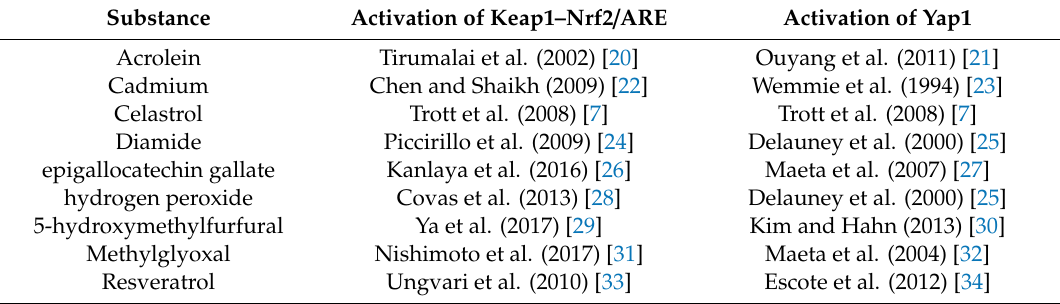
Table 1. A selection of substances shown to activate both the Keap1–Nrf2 / ARE and Yap1 oxidative stress response systems in mammals and in yeast,